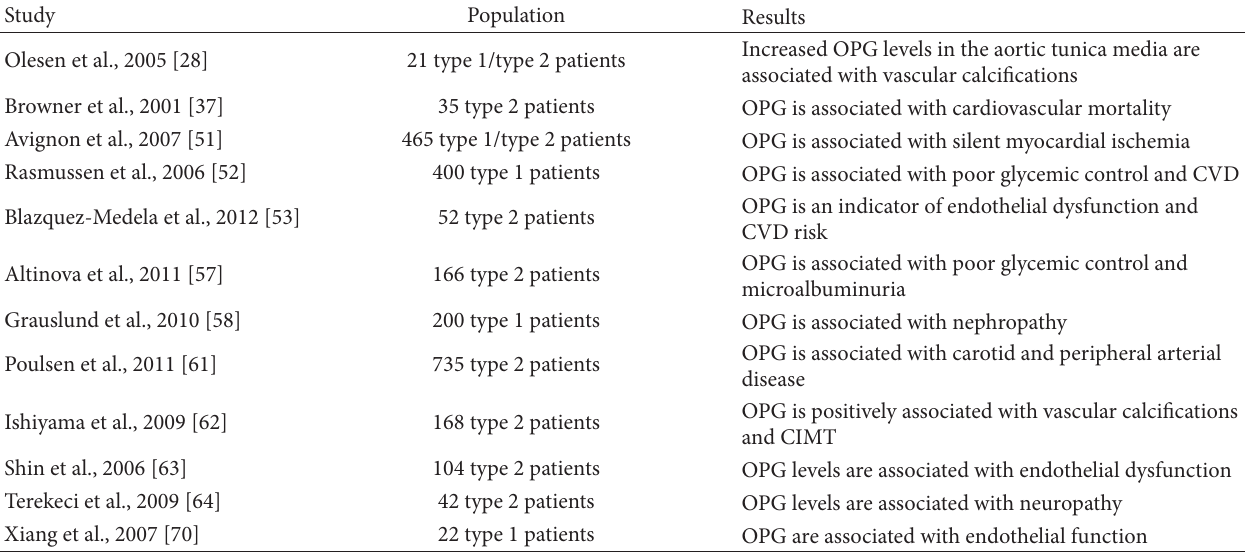
T1: StudiesevaluatingtheassociationofOPGlevelswith indicesofglycemiccontrol,subclinicalatherosclerosis,orcardiovascularevents in diabetic